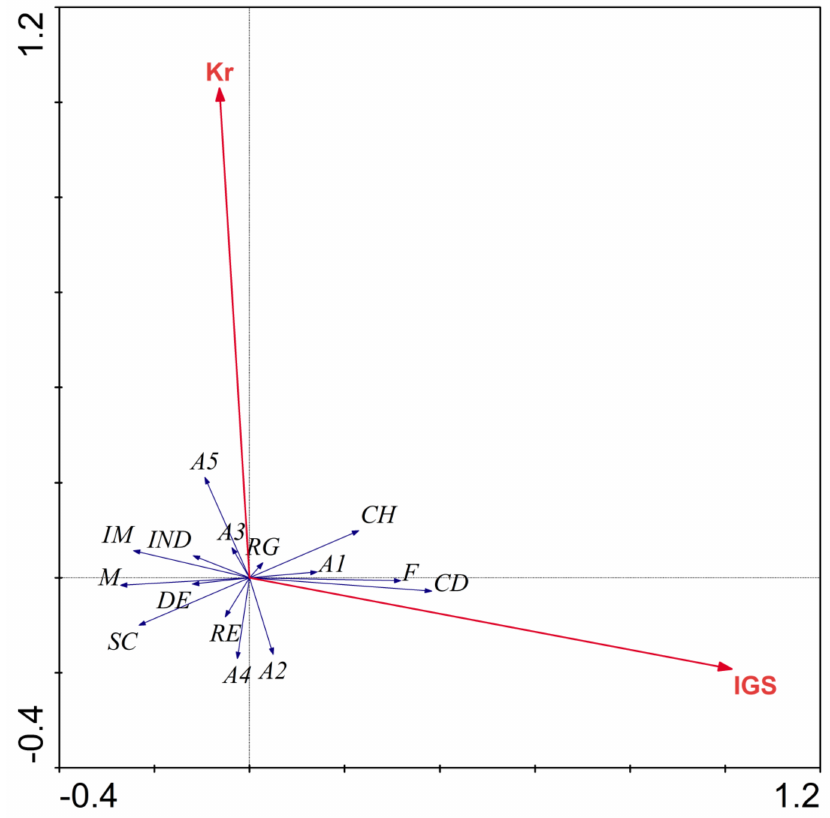
Figure 7. Ordination diagram (biplot) of the Redundancy Analysis (RDA) of reproductive indices and frequency of Genyatremus luteus specimens collected from April/16 to April/17 in Ajuruteua peninsula, Bragança, PA, Brazil. Seasonal periods (RP: rainy period, DP: dry period); maturation stages (IM: immature, DE: development, SC: spawning − capable, RG: regression, RE: regeneration, UND: undetermined), areas (A1: area 1, A2: area 2, A3: area 3, A4: area 4, A5: area